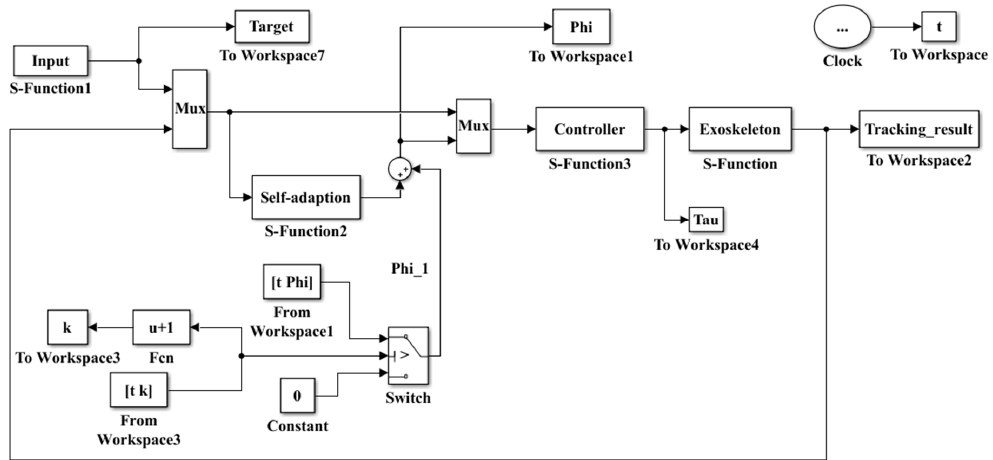
Figure 3. The simulation block diagram for the AILC-based gait tracking.